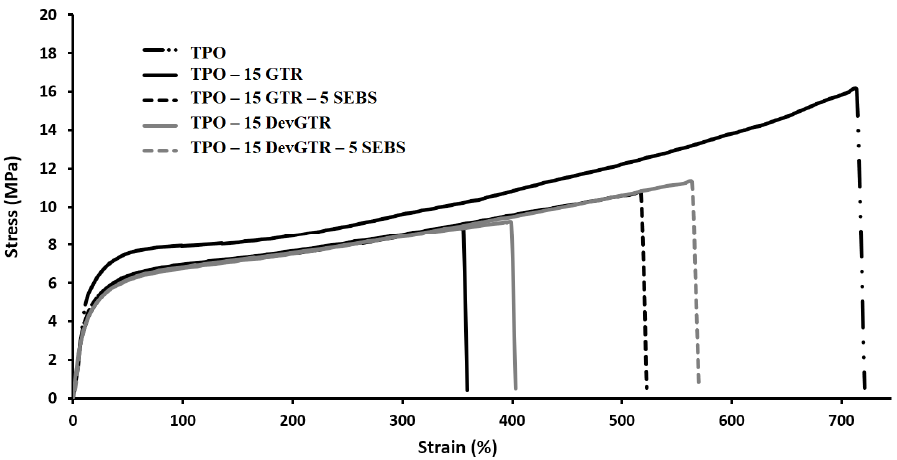
Figure 8. Stress–strain curves of TPO and TPO-recycled tire rubber blends as prepared by 3D printing. Table 6. Mechanical properties (tensile and impact tests) of TPO-based composites loaded with recycled GTR or DevGTR, containing or not